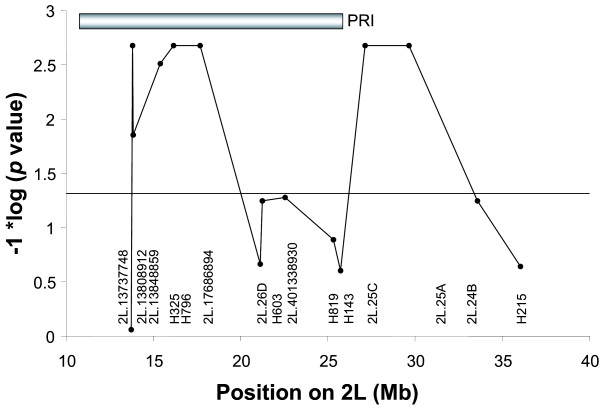
Mapping of the chromosomal region containing EA_Pfin1. Nominal p values are plotted as a function of physical position. For reference, a value of 1.3 on the transformed y-axis corresponds to a p value of 0.05, shown as a horizontal line. The order of markers uses the inverted (2La/a) conformation of the 2L chromosome. Only the most informative markers (≥2 alleles and ≥3 genotypes) are shown. Only markers H796, H17686896, and H25C are fully informative, that is, segregate 4 alleles so that a unique microsatellite allele marks each parental chromosome that entered the pedigree. The dip in the center of the plot is likely due to a lack of marker informativeness.